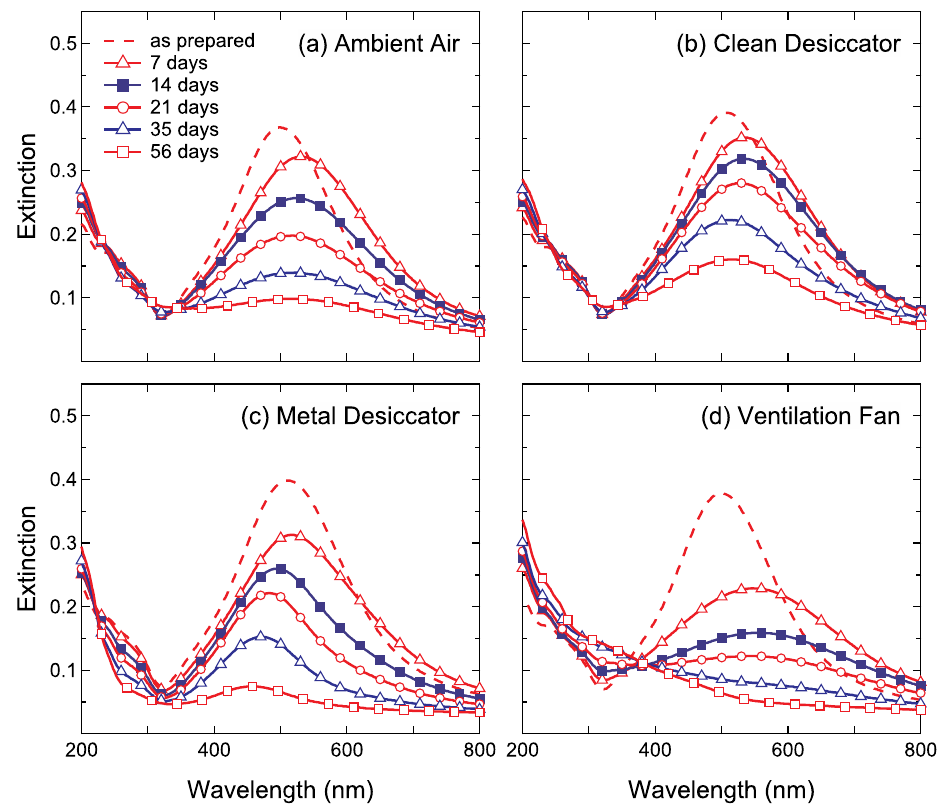
Figure 3. The optical extinction spectra of Ag/SiO 2 stored ( a ) in ambient air, ( b ) inside the clean desiccator, ( c ) inside the metal desiccator and ( d ) near the ventilation fan. at room temperature for 7 days (open triangles), 14 days (filled squares), 21 days (open circles), 35 days (open triangles), 56 days (open squares). The spectrum of as-prepared sample (dashed lines) is also shown for comparison. NPs/HOPG aged in vacuum for 7 days. As shown in Figure 4a, a high-energy edge appears at approximately 0.51 MeV, corresponding to the scattering 2 MeV- 4 He ions from the C substrate. Even for the as-prepared Ag NPs/HOPG, small peaks corresponding to extrinsic contaminants of N (~0.63 MeV), O (~0.73 MeV) and S (~1.22 MeV) were detected. 44 days. For the Ag NPs/HOPG stored in ambient air, into the clean desiccator and into the metal desiccator, N, O and S were detected. In addition to these elements, a small amount of Cl was detected on Ag NPs/HOPG stored in ambient air for 44 days. In the RBS spectra of Ag NPs/HOPG stored near the ventilation fan, peaks corresponding to contaminant elements such as N, O, S, Cl were found. In addition to assignable peaks for such contaminants, there are some peaks, for example, at energies of 1.64 MeV (in its poor mass resolution for heavy elements. Therefore, we tried to detect trace amounts of heavy element impurities adsorbed on Ag NPs by PIXE analysis using proton